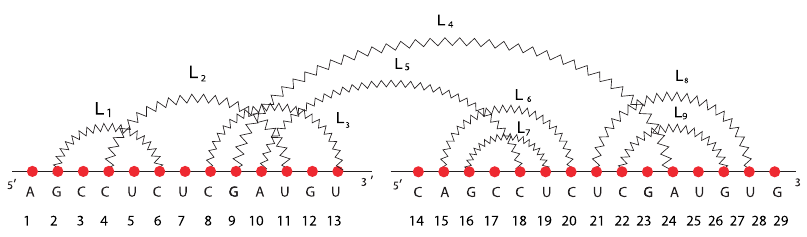
Figure 5: Example of an RNA secondary structure.